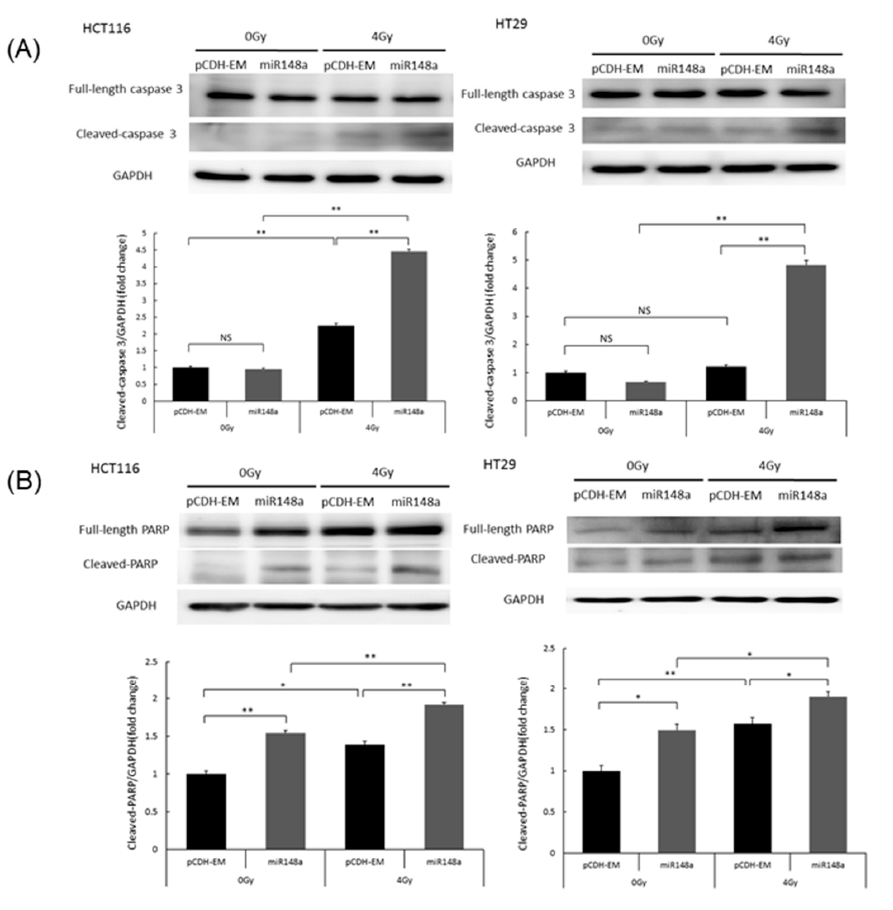
Figure 5. miRNA ‐ 148a promoted apoptosis in irradiated HCT116 and HT29 cells. Following irradiation with 0 or 4 Gy, the cells were harvested, and the total protein was extracted for Western blotting. (A) miR ‐ 148a enhanced the irradiation ‐ induced upregulation of cleaved caspase ‐ 3 (N = 3; * p < 0.05; ** p < 0.01). (B) miR ‐ 148a enhanced the irradiation ‐ induced upregulation of cleaved poly (ADP ‐ ribose) polymerase (N = 3; * p < 0.05; ** p < 0.01). 3.6. miRNA ‐ 148a Overexpression Promoted Apoptosis in CRC Cells by Directly Targeting c ‐ Met The potential target gene of miRNA ‐ 148a was explored using the TargetScan pro ‐ gram. The analysis indicated the presence of a conserved binding site of miRNA ‐ 148a in the 3 ′ UTR of c ‐ Met (Figure 6A). The luciferase reporter assay demonstrated that the rela ‐ tive luciferase activity of the reporter vector containing WT c ‐ Met ‐ 3 ′ UTR was significantly suppressed by miRNA ‐ 148a. By contrast, miRNA ‐ 148a did not influence the relative lu ‐ ciferase activity of the mutated reporter ( p < 0.001; Figure 6B). Moreover, miRNA ‐ 148a overexpression significantly inhibited c ‐ Met protein expression ( p < 0.01; Figure 5). In HCT116 cells with pCDH ‐ NC, irradiation induced upregulation of phosphorylated c ‐ Met, which was suppressed by miRNA ‐ 148a (Figure 6C). However, in HT29 cells transfected with pCDH ‐ NC, irradiation did not upregulate phosphorylated c ‐ Met (Figure 6D).